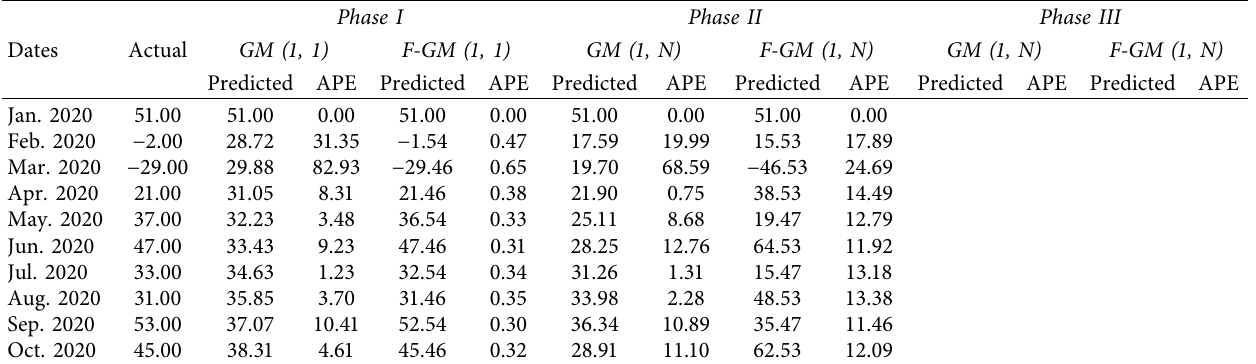
Table 8: Prediction results of travel sentiment in